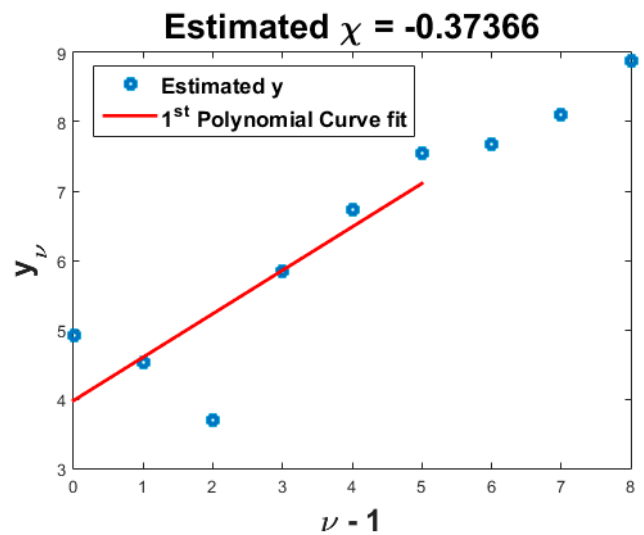
Figure 8. Estimated y in Equation (35) ( ○ ), results of curve fit with 1 st polynomial equation ( — ) and estimated χ from the curve fitting results.